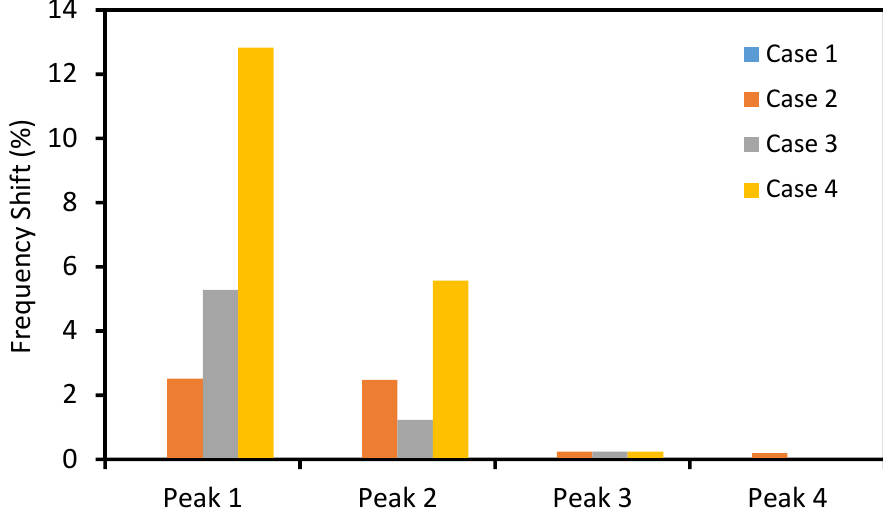
Figure 11. The frequency shift for different cases of contact stiffness.